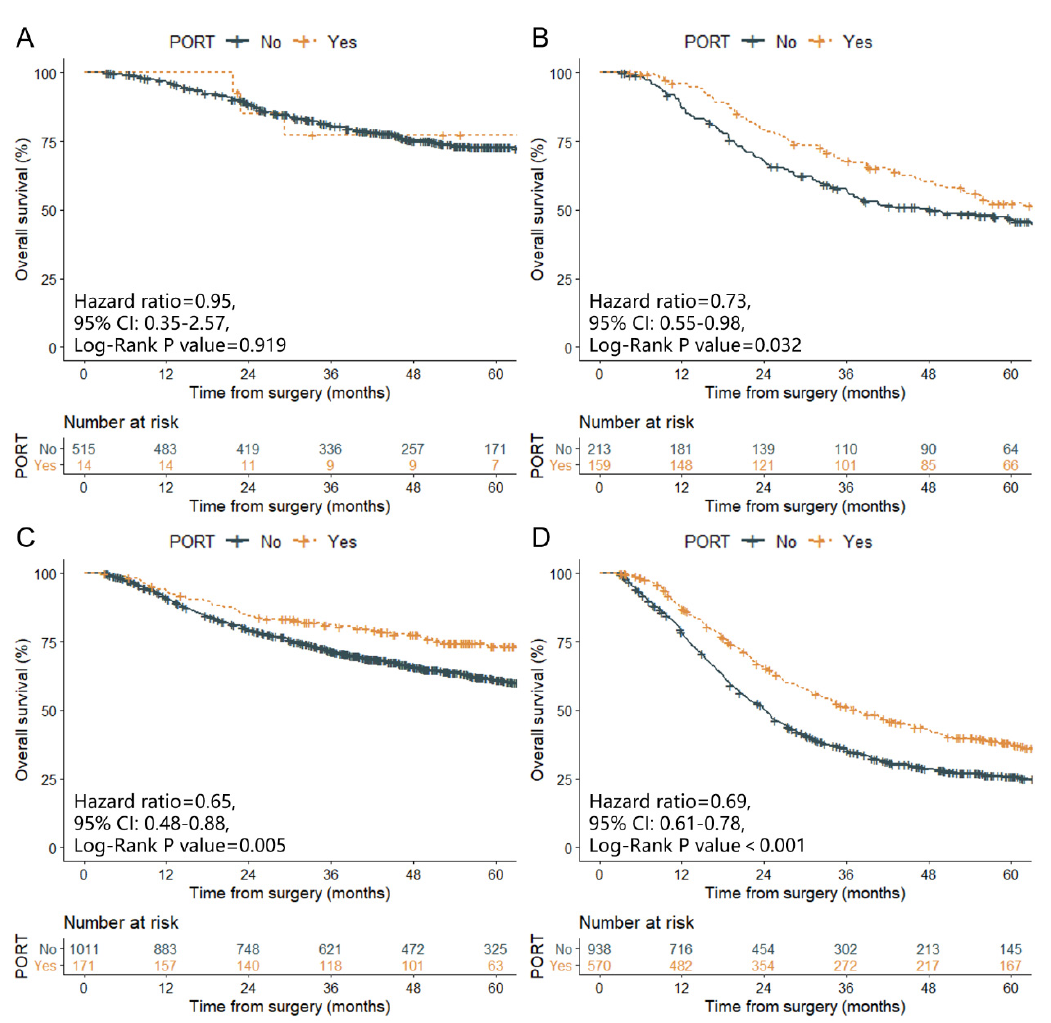
Figure 1. Overall survival of patients with pathologic stage of T1–2N0 ( A ), T1–2N1–3 ( B ), T3–4N0 ( C ), and T3–4N1–3 ( D